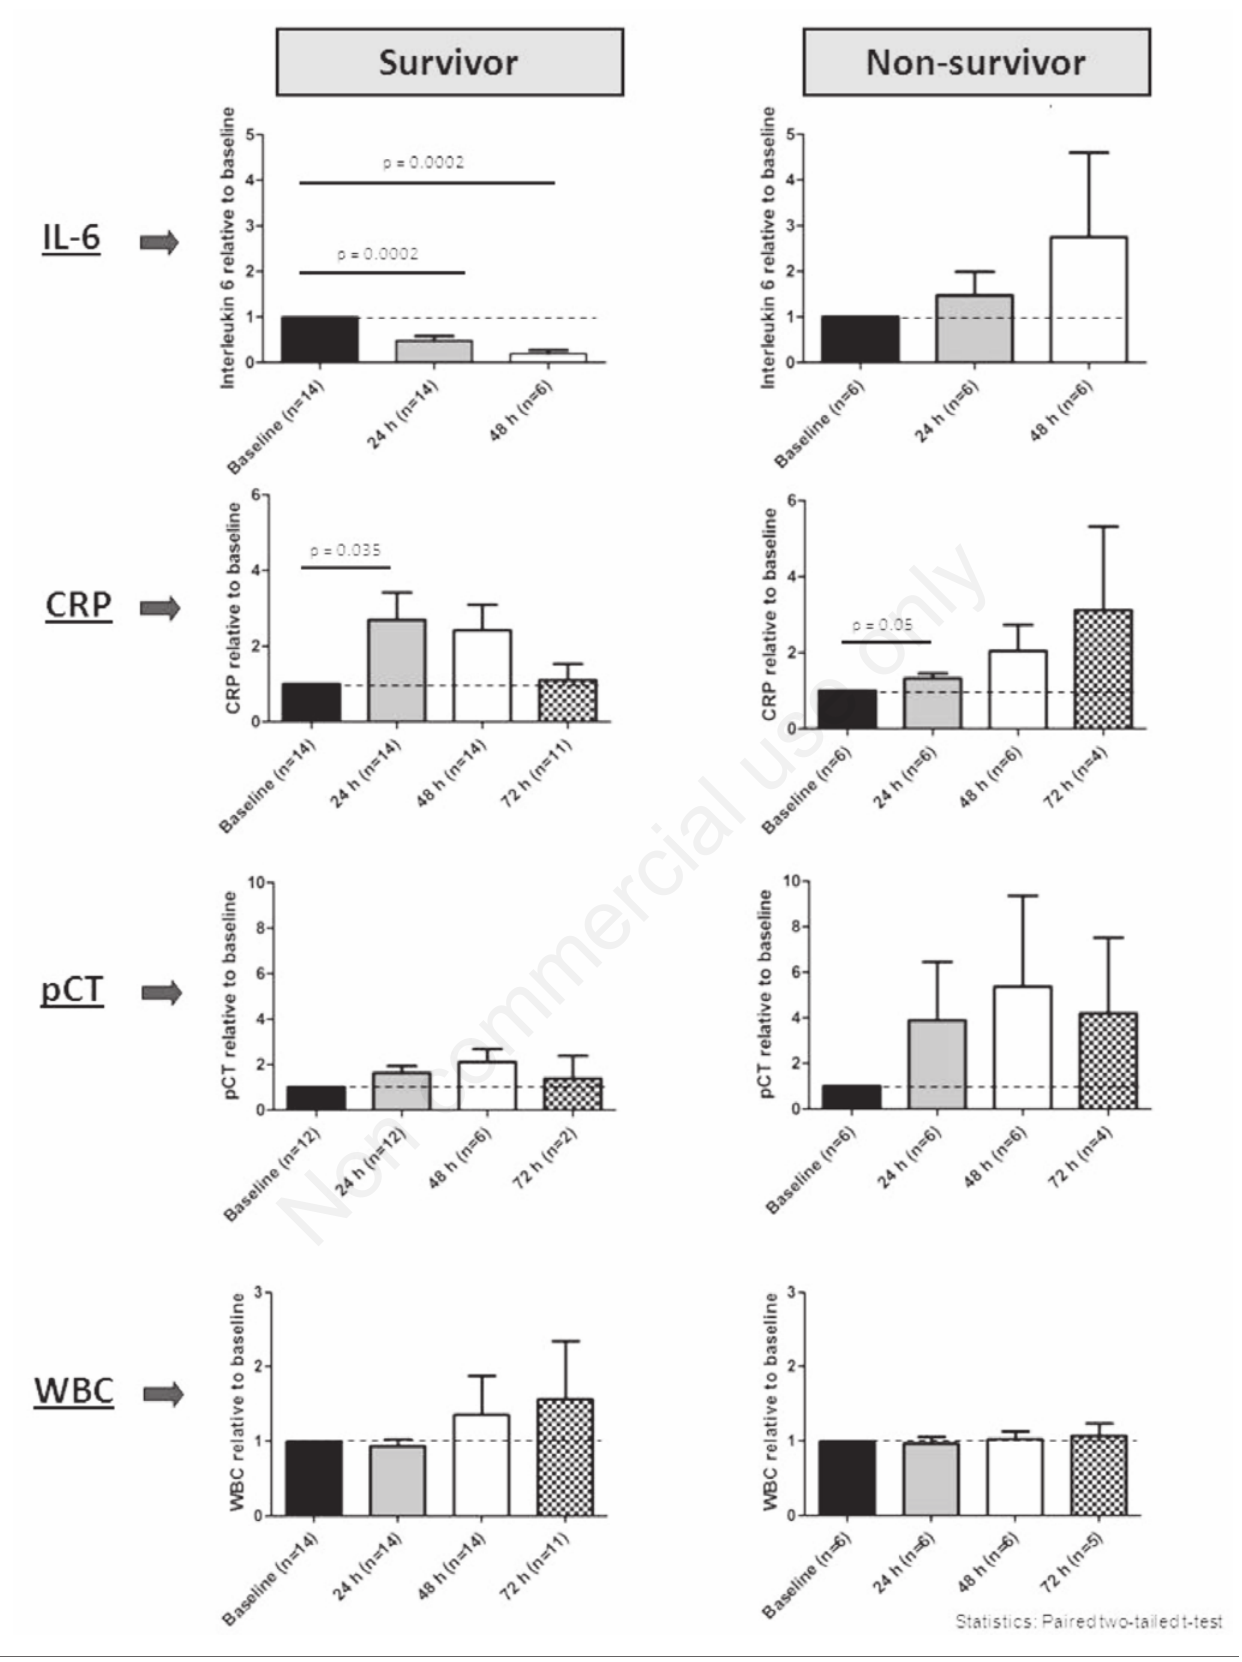
Figure 1. Relative biomarker kinetics of IL-6, CRP, PCT and WBC for survivors and non-survivors in the first 72 hours after start of sepsis therapy. Values are plotted relatively, as fold change of baseline values (all mean values). For statistical testing the paired two- tailed t-test was used. A P<0.05 is considered as statistically